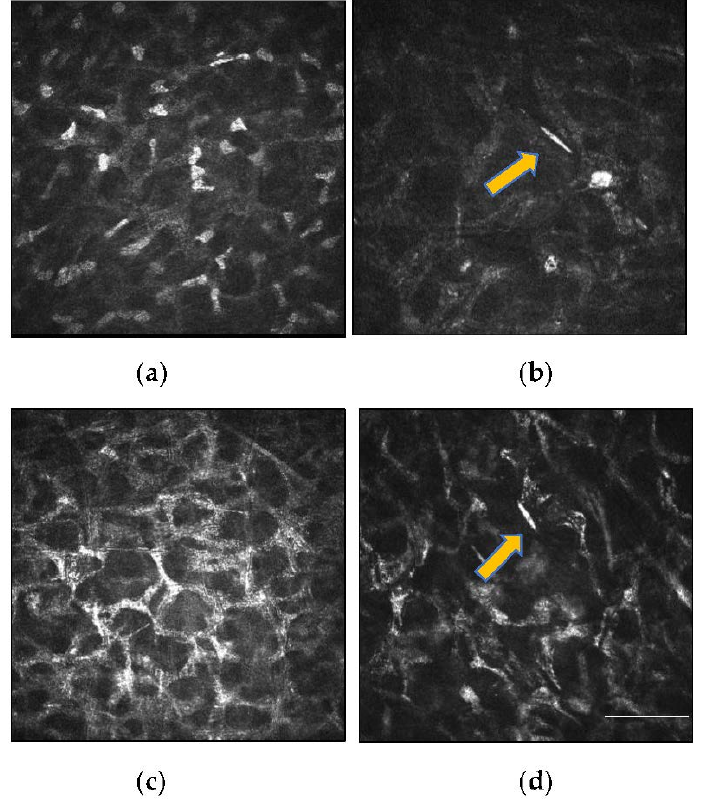
Figure 4. IVCM images of the anterior corneal stroma after CXL. ( a ) Rarefaction of keratocytes and elongated nuclei (masked necrotic keratocytes) are observed. ( b ) Reduction in keratocyte density with the presence of a fine needle-like opacity (yellow arrow), suggestive of apoptosis of keratocytes. ( c ) Anterior stromal honeycomb similar to edema, comprising of hyper-reflective cytoplasm and extracellular lacunae are evident ( d ). Repopulation of the cross-linked area with activated keratocytes. A needle-like opacity (yellow arrow) is also detectable, indicating apoptotic keratocytes. Scale bar: 100 µ